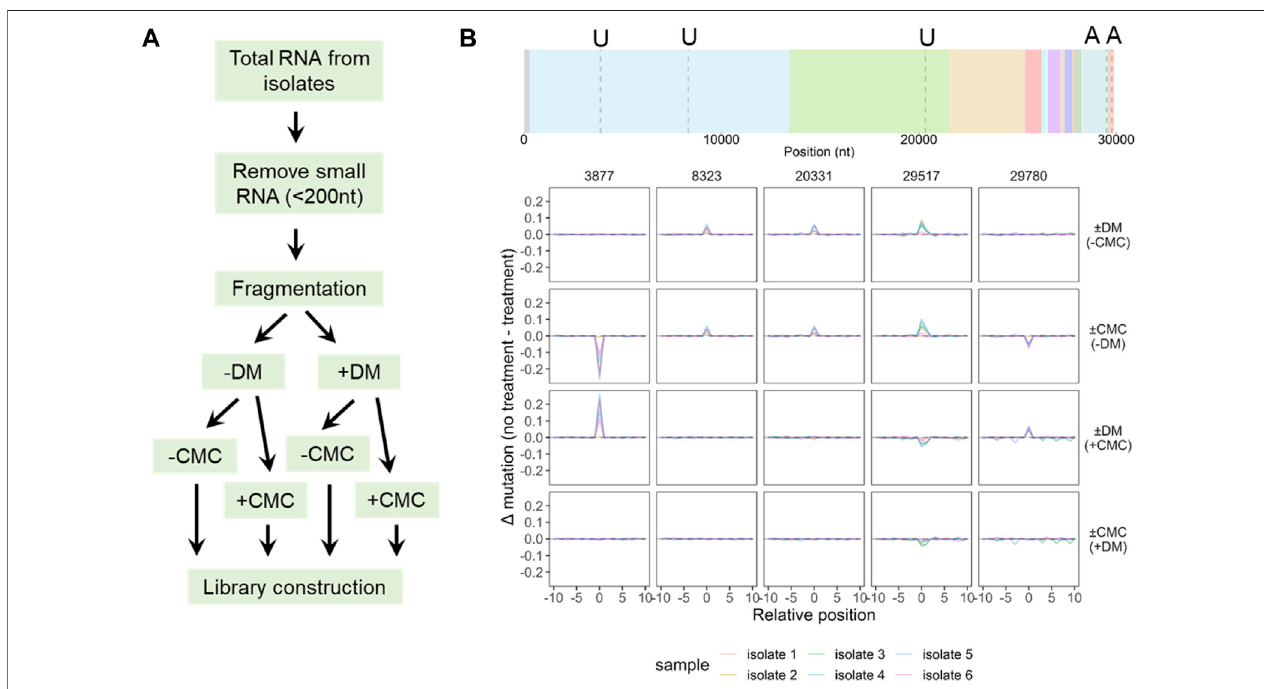
FIGURE 6 | Large RNA sequencing identi fi es candidate SARS-CoV-2 modi fi cations. (A) Scheme of modi fi cation detection. An enzyme treatment (DM) and a chemical treatment (CMC) are added before library construction, producing four combinations for each sample. (B) Candidate modi fi cations from comparing four treatment conditions. Site locations are indicated in adashed line,nucleotide identity indicated on top of theSARS-CoV-2 gene map. Datafrom top tobottom: with and withoutdemethylaseonly(±DM,-CMC);withandwithoutCMConly(±CMC,-DM),withandwithoutdemethylase,alsoCMC(±DM,+CMC);withandwithoutCMC, also DM (±CMC, +DM). Positions with mutations > 5% in at least 4 of the 6 isolates but excluding the SNP positions in Figure 5A are